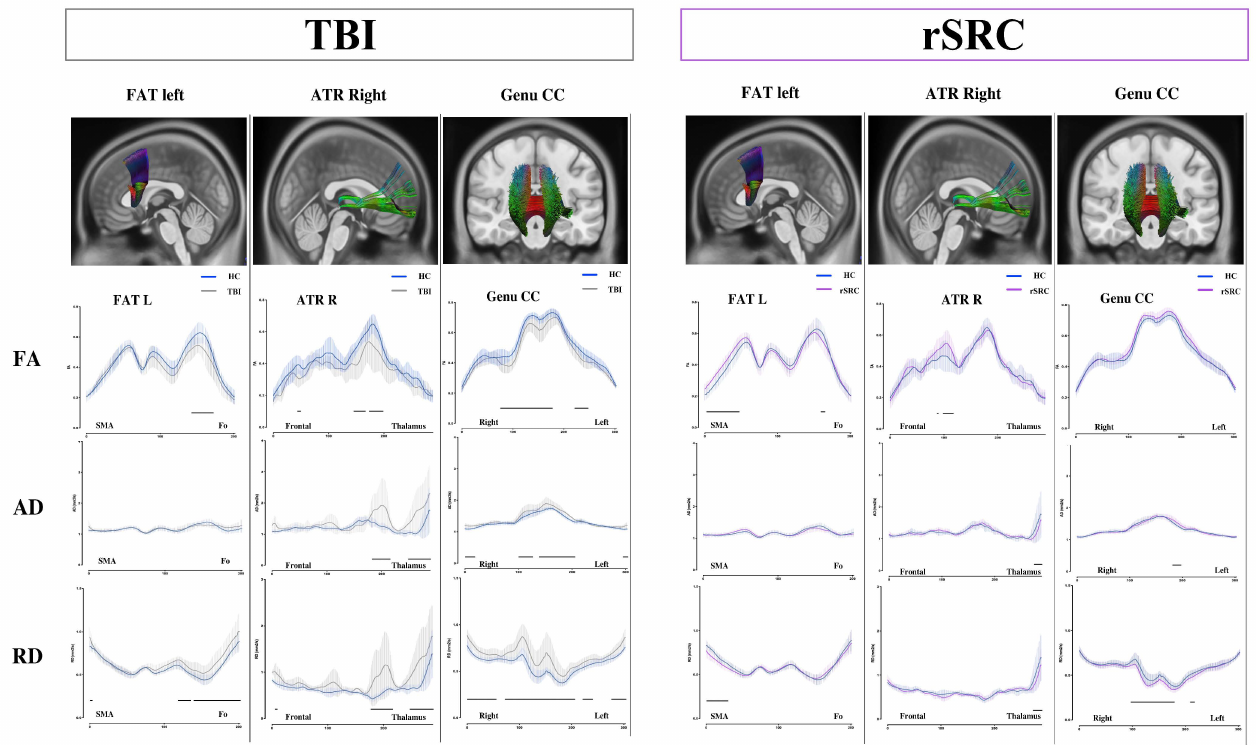
Figure 1. Focal analysis of three white matter pathways with white matter changes identified in both TBI patients and in rSRC patients compared with HC. False discovery rate (FDR) analysis was performed, as such significant differences are displayed as continuous lines on the x axis of each DTI- based parameter for each white matter pathway. The left frontal aslant tract (FAT) displayed lower FA and higher RD in the fronto-opercular region in TBI patients, while a higher FA and lower RD in the supplementary motor area region were found in the rSRC group. The right anterior thalamic radiation (ATR) displayed lower FA and higher AD and RD in the TBI group localized mostly at the thalamic level, while the rSRC group displayed higher FA and lower AD and RD mostly at the thalamic level. The genu of the corpus callosum (CC) showed lower FA and higher AD and RD in the TBI group close to the midline, while the rSRC group displayed a higher AD and lower RD close to the midline. TBI: traumatic brain injuries; rSRC: repeated sport related concussions; HC: healthy controls; AD: axial diffusivity; RD: radial diffusivity; FAT: frontal aslant tract; ATR: anterior thalamic radiation; CC: corpus